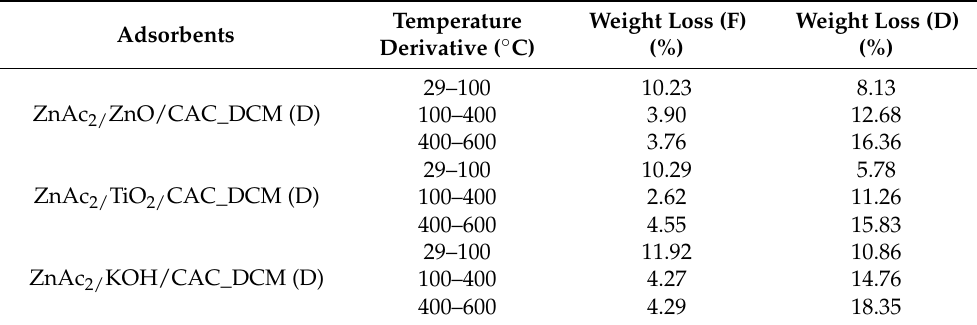
Table 8. Comparison of weight losses (%) with temperature derivatives in TGA for fresh and exhausted DCM/CAC